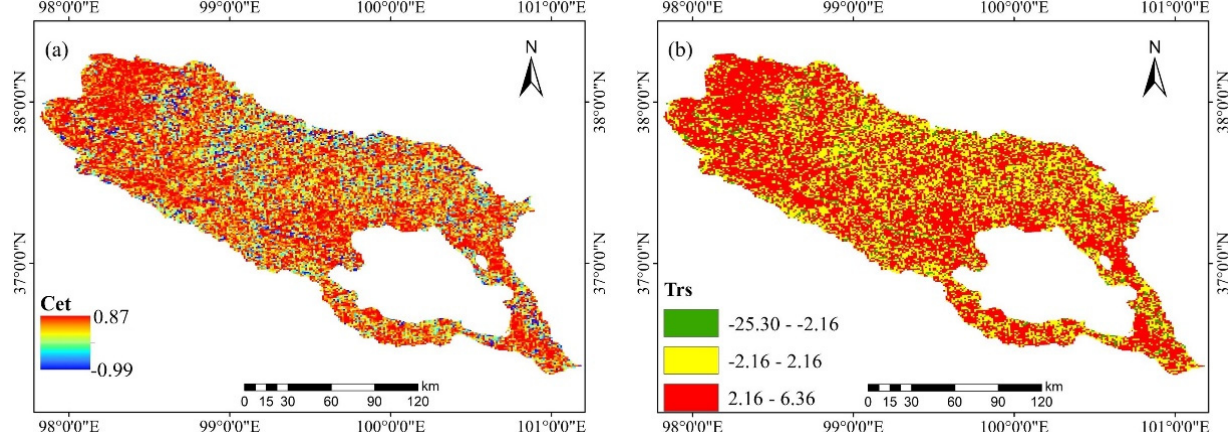
Figure 9. Spatial correlations of NDVI with VWC ( a ) and the t-test results ( b ) in the Qinghai Lake Basin from 2000 to 2014. Cet and Trs represent correlation coefficient and the t-test results, respectively.